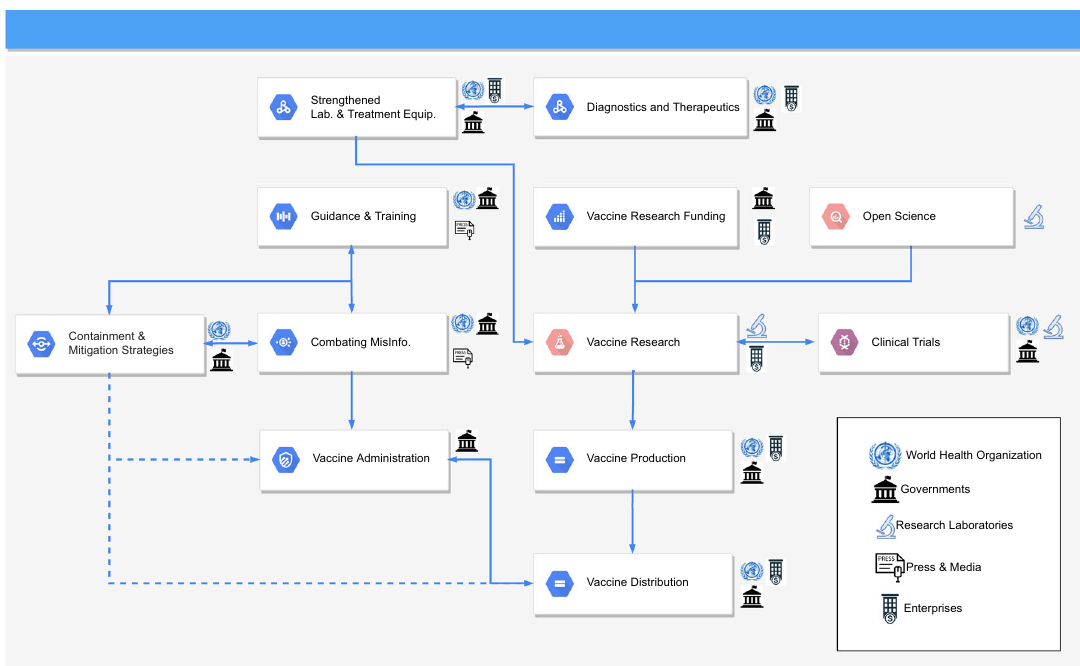
Fig. 2 The 3D process of vaccine development and